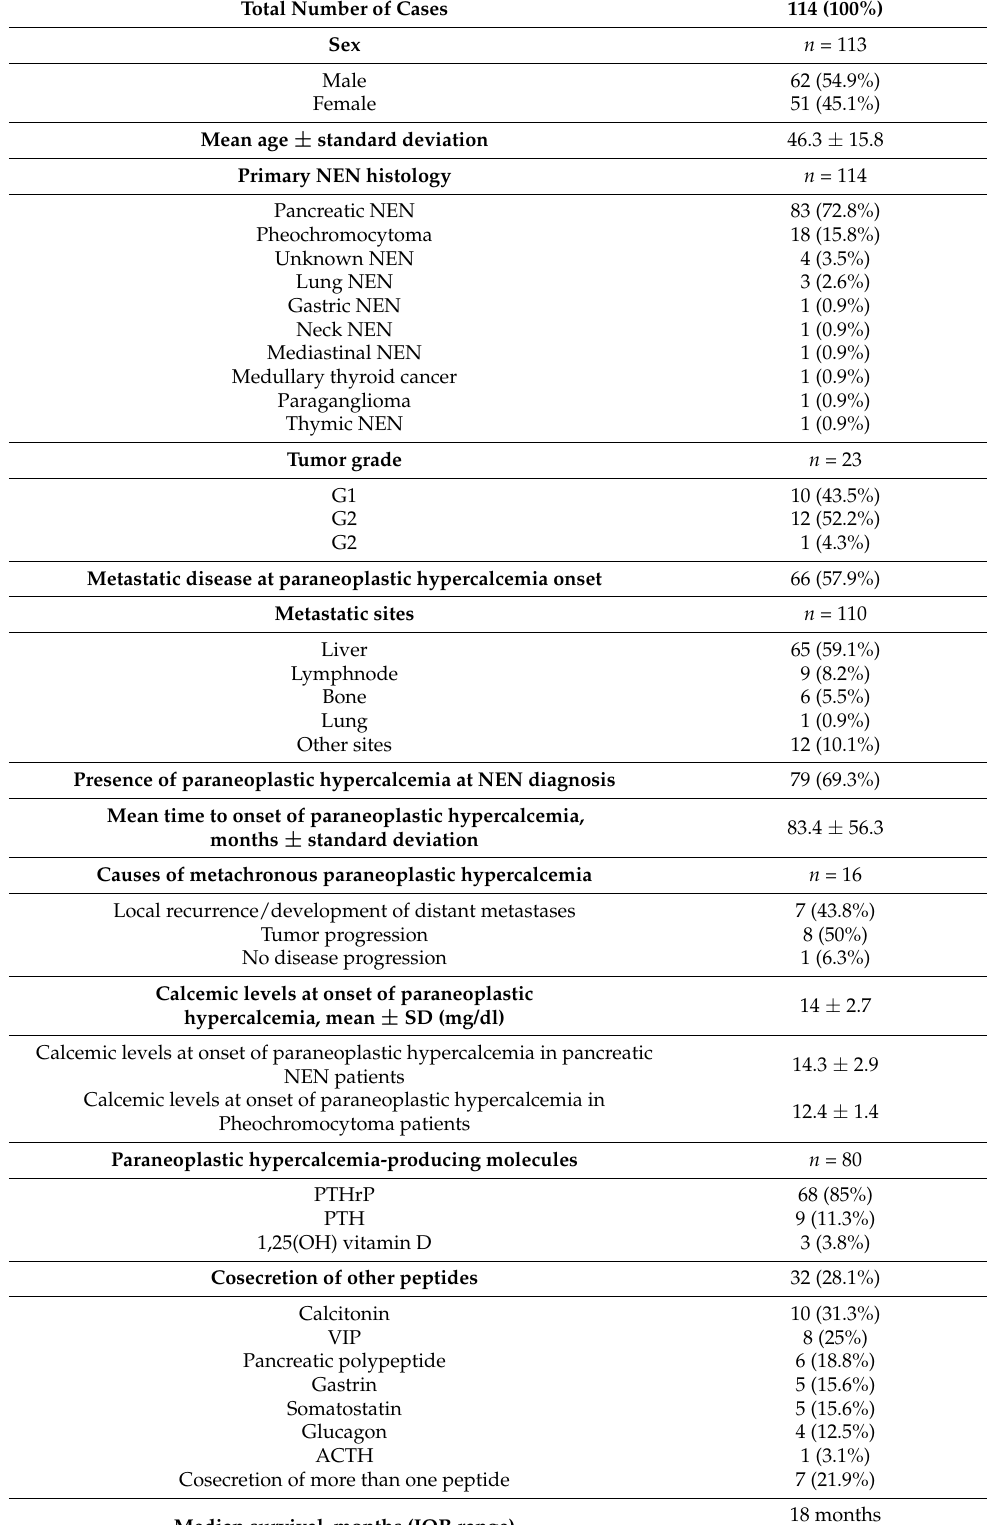
Table 2. Demographic, pathological, and clinical characteristics of well-differentiated NEN patients with paraneoplastic hypercalcemia reported in the